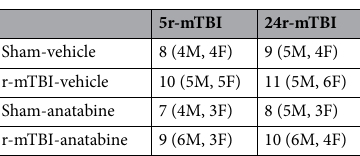
Table 1. Distribution of mice in the experimental groups (M-males,